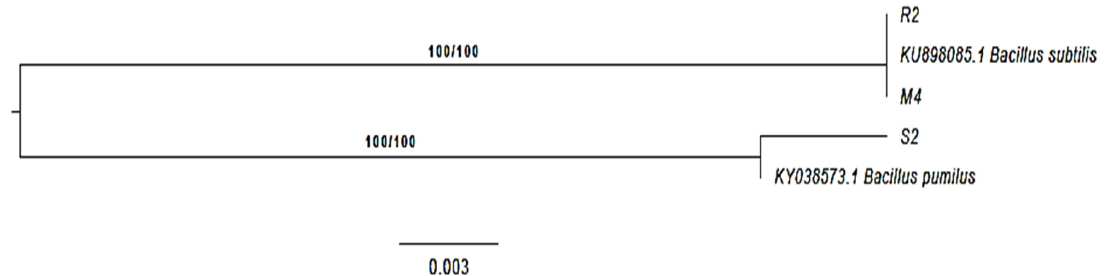
Figure 2. Phylogenetic relationships of 12 isolates belongs to the four references bacteria species based on 16S rDNA gene sequences. S2 represents Bacillus pumilus; M4 and R2 represent Bacillus subtilis; P1, R2 and M2 represent Paenibacillus spp and S1, P2, R3, M3, S3, S4 represent Geobacillus stearothermophilus . The branching pattern was generated by the neighbor-joining method. Bootstrap values are indicated at the node.